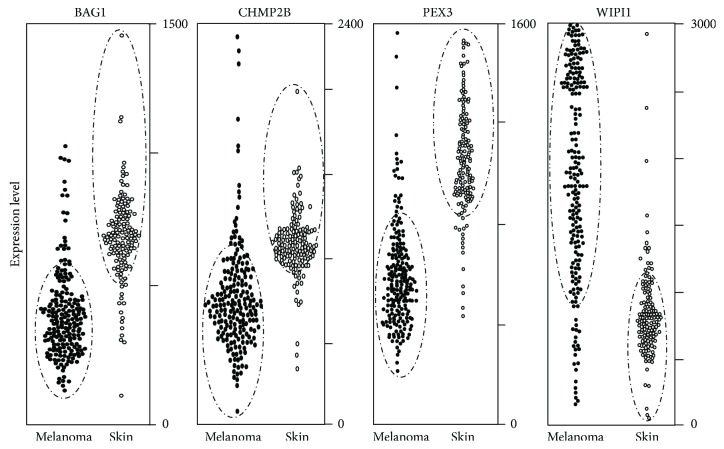
Gene expression according to the IST online database. The four reported genes show different expression levels in melanoma vs healthy skin. The expression level of each gene is reported in 208 melanoma biopsies and 147 healthy skin biopsies, according to the IST Online database. Gating indicated with dashed lines include 90% of melanoma and 90% of ctrl skin samples. PEX3, BAG1, and CHMP2B expression in melanoma is clearly lower than healthy skin. WIPI1 expression in melanoma is clearly higher than healthy controls.